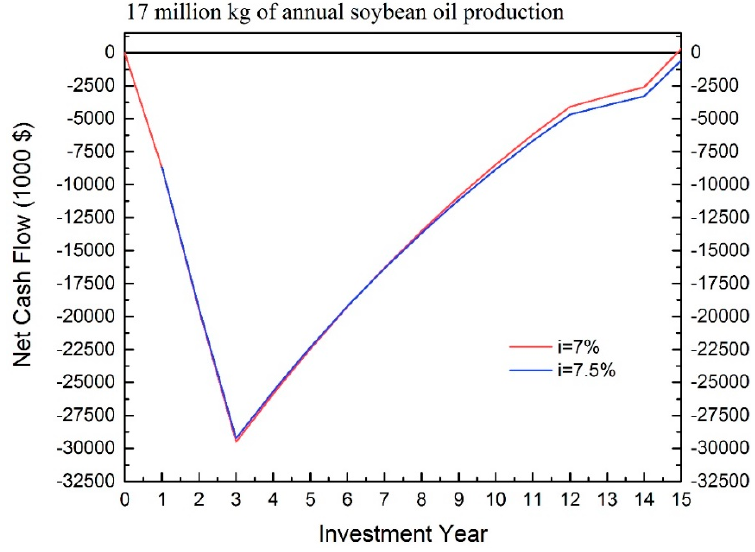
Figure 6. IRR prediction for EAEP.